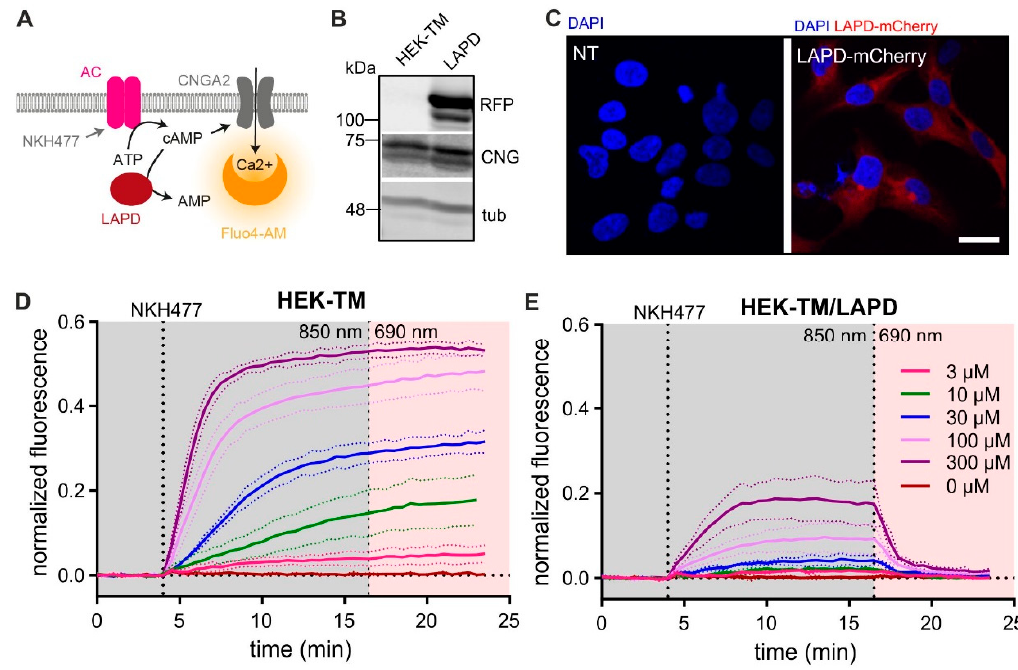
Figure 1. Characterization of LAPD in HEK-TM cells. ( A ) Scheme illustrating the principle of the assay used to measure LAPD activity in HEK cells via cAMP-gating of a Ca 2 + -permeable cyclic nucleotide-gated ion channel (CNGA2-TM) [19]. HEK-TM cells were first stimulated with 100 µ M NKH477 to activates transmembrane adenylate cyclases (AC). The ensuing increase in cAMP evokes a Ca 2 + influx that is detected by a fluorescent Ca 2 + indicator (Fluo4-AM). Subsequently, cells were illuminated to stimulate LAPD activity. ( B ) Western blot analysis of LAPD-mCherry expression in HEK-TM cells (LAPD). Non-transfected cells (HEK-TM) were used as a control. Immunoblots were stained with RFP, CNGA2, and alpha-tubulin antibodies. ( C ) Immunocytochemical analysis of LAPD-mCherry expression in HEK-TM cells. Non-transfected cells (NT) were used as a control. Cells were stained with DAPI (blue) to label the DNA; scale bar: 10 µ m. ( D , E ) Measuring LAPD activity. Fluo4-AM-loaded HEK-TM cells were incubated with increasing concentrations of NKH477 (see legend in E) during continuous 850 nm light illumination (grey, 0.5 µ W / cm 2 ). When reaching a steady-state, light was switched to 690 nm (red, 0.5 µ W / cm 2 ) to stimulate LAPD activity. To evoke a maximal Ca 2 + response, cells were stimulated at the end of the experiment with 2 µ M ionomycin for normalization (data not shown). Data are shown as mean ± S.D. Panels (D) and (E) show data for non-transfected HEK-TM cells and stable LAPD-mCherry lines, respectively.